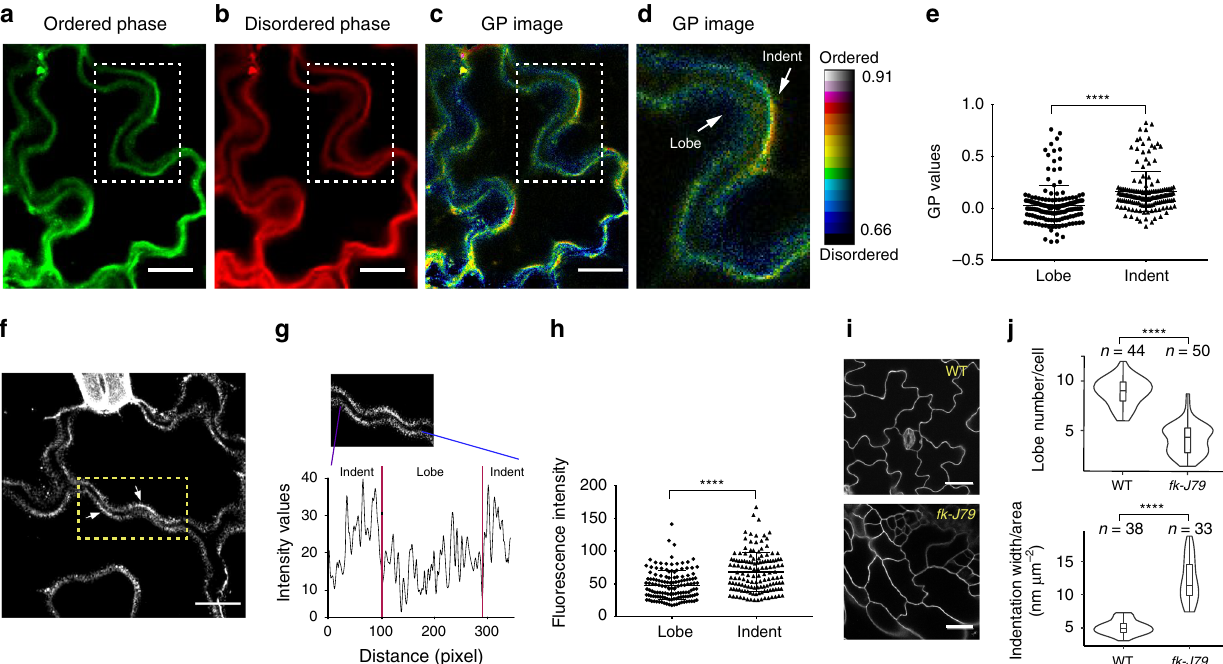
Fig. 1 Ordered membrane domains are preferentially localized to indenting regions. a , e Plasma membrane order visualization using di-4-ANEPPDHQ staining in the pavement cells of 2 – 3-day-old Arabidopsis cotyledons (Col-0). a – d Representative images obtained after di-4-ANEPPDHQ staining. a Di-4- ANEPPDHQ fl uorescence recorded between 500 and 580 nm, representing high lipid ordering. b Di-4-ANEPPDHQ fl uorescence recorded between 620 and 750 nm, representing low lipid ordering. c A radiometric color-coded GP image generated from a and b 28,29 . d An enlarged GP image corresponding to the boxed areas in c . The GP image is a false-color image, which runs over the range indicated by the color bar. Color bar values represent GP values ascend from bottom to top, with red colors indicating high membrane ordering, whereas blue colors indicating low membrane ordering. Scale bars = 15 µ m. e Quantitative analysis of mean GP values obtained from the complementary lobing and indenting regions of 161 sites of 56 cells from three independent experiments. GP values at indenting regions are signi fi cantly higher than that at lobing regions. f – h Flotillin1-mVenus shows a polar distribution toward indenting regions. f Representative image showing the distribution of fl otillin1-mVenus in PCs of 2 – 3-day-old cotyledons. The region highlighted in the dotted-line box is further analyzed in g . Scale bars = 15 µ m. g Fluorescent intensity values scanned along the indicated region in f . h Quantitative analysis of fl uorescence intensity at the complementary lobing and indenting regions of 138 sites of 45 cells from three independent experiments. i , j The sterol biosynthesis mutant fackel-J79 ( fk-J79) , which is defective in gene encoding a sterol C14 reductase, shows altered PC shape. i Representative images of cotyledon pavement cells in fk-J79 mutant and its corresponding wild type. Scale bars = 30 µ m. j Quantitative analysis of the number of lobes and indentation widths in PCs of fk-J79 mutant and its wild type. n represents the number of cells. Data are representative of three independent experiments which have the same pattern. **** P ≤ (Fig. 1f – h; Supplementary Movie 4). Collectively, these results show that ordered lipid domains are preferentially distributed to indenting regions of the PM, as is the active ROP6 GTPase 26 .